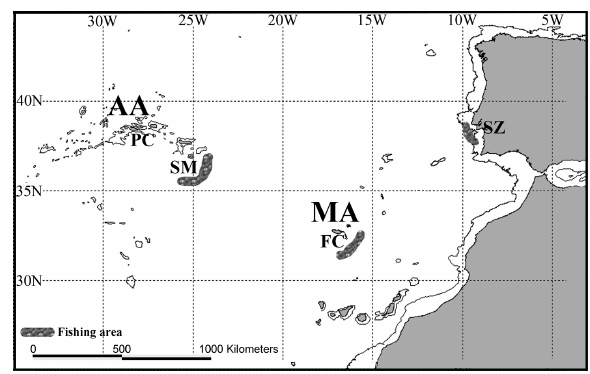
Fig . 1. – Map of the southern northeast atlantic with the sampling locations of black scabbardfish and the 1000 m isobath. aa, azores archipelago; FC, Funchal; Ma, Madeira archipelago; PC, Pico is- land; sM, santa Maria island; sz, sesimbra (mainland